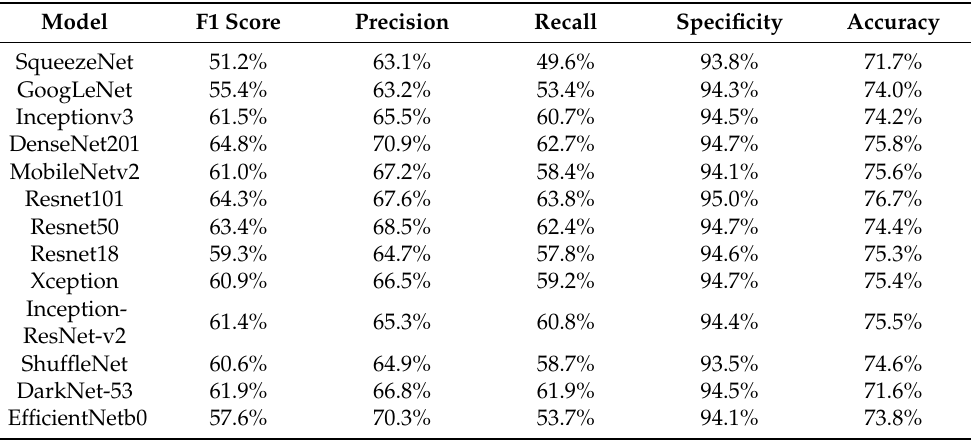
Table 1. The mean overall Accuracy, F-score, Precision, Recall, and Specificity for each deep learning model and 70/30 data